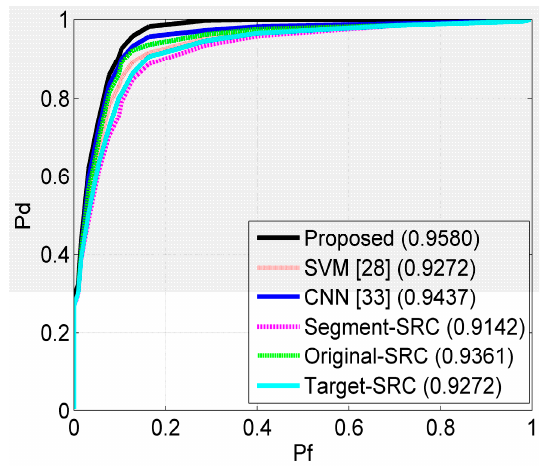
Figure 12. The ROC curves of different methods. (ROC: receiver-operating characteristics)